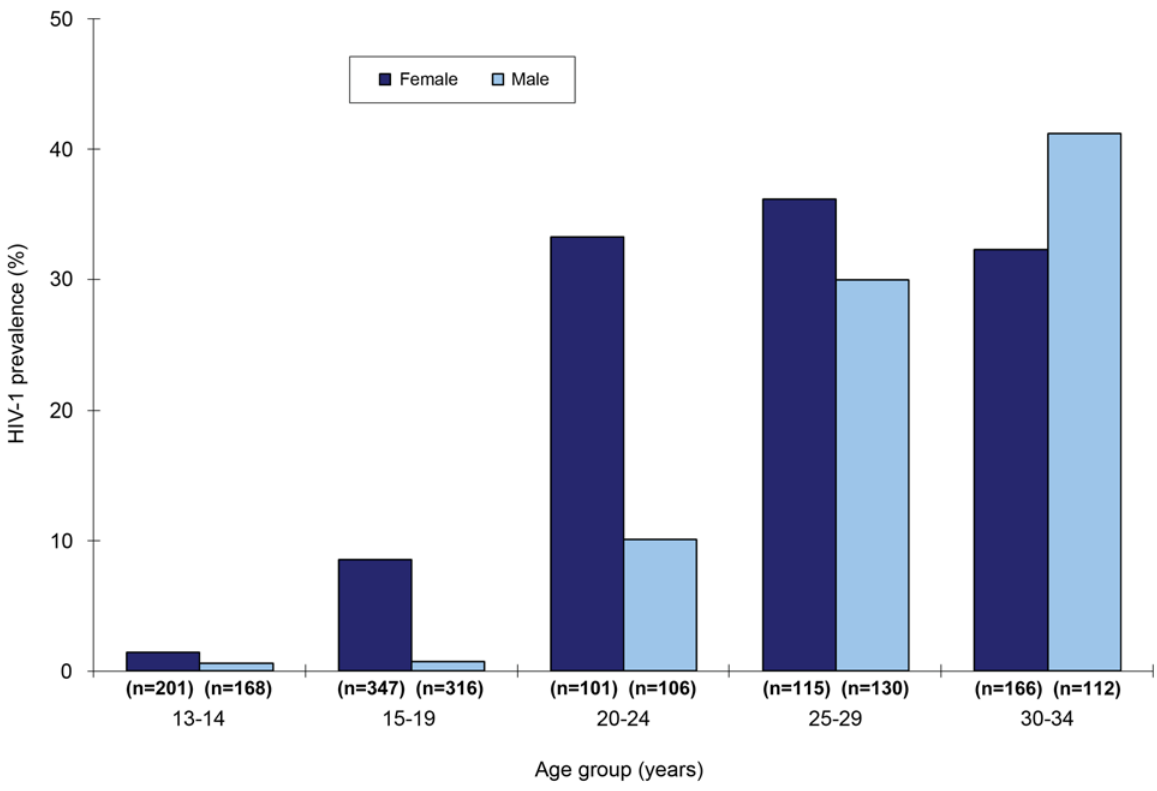
Figure 1. HIV prevalence by sex and age-group, N=1762.